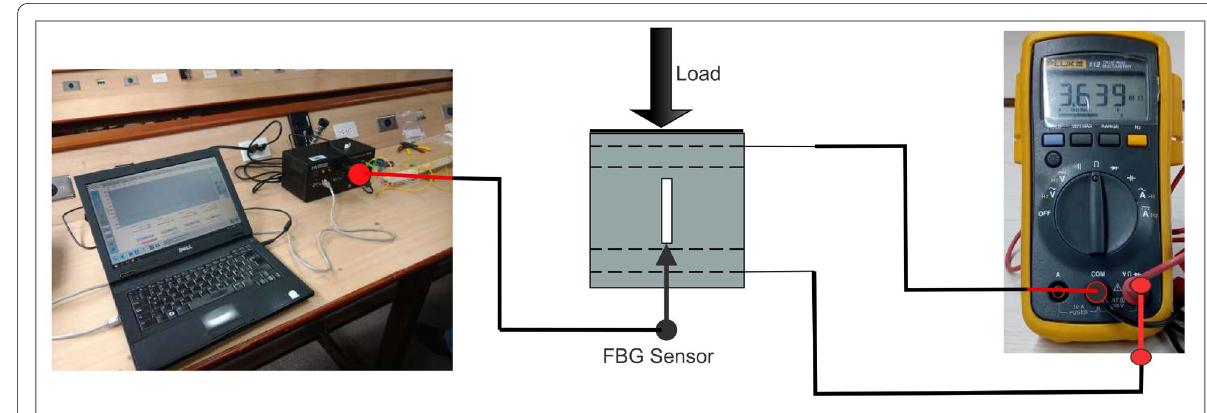
Fig. 4 Experimental setup for CBM/CNT piezoresistivity determination.